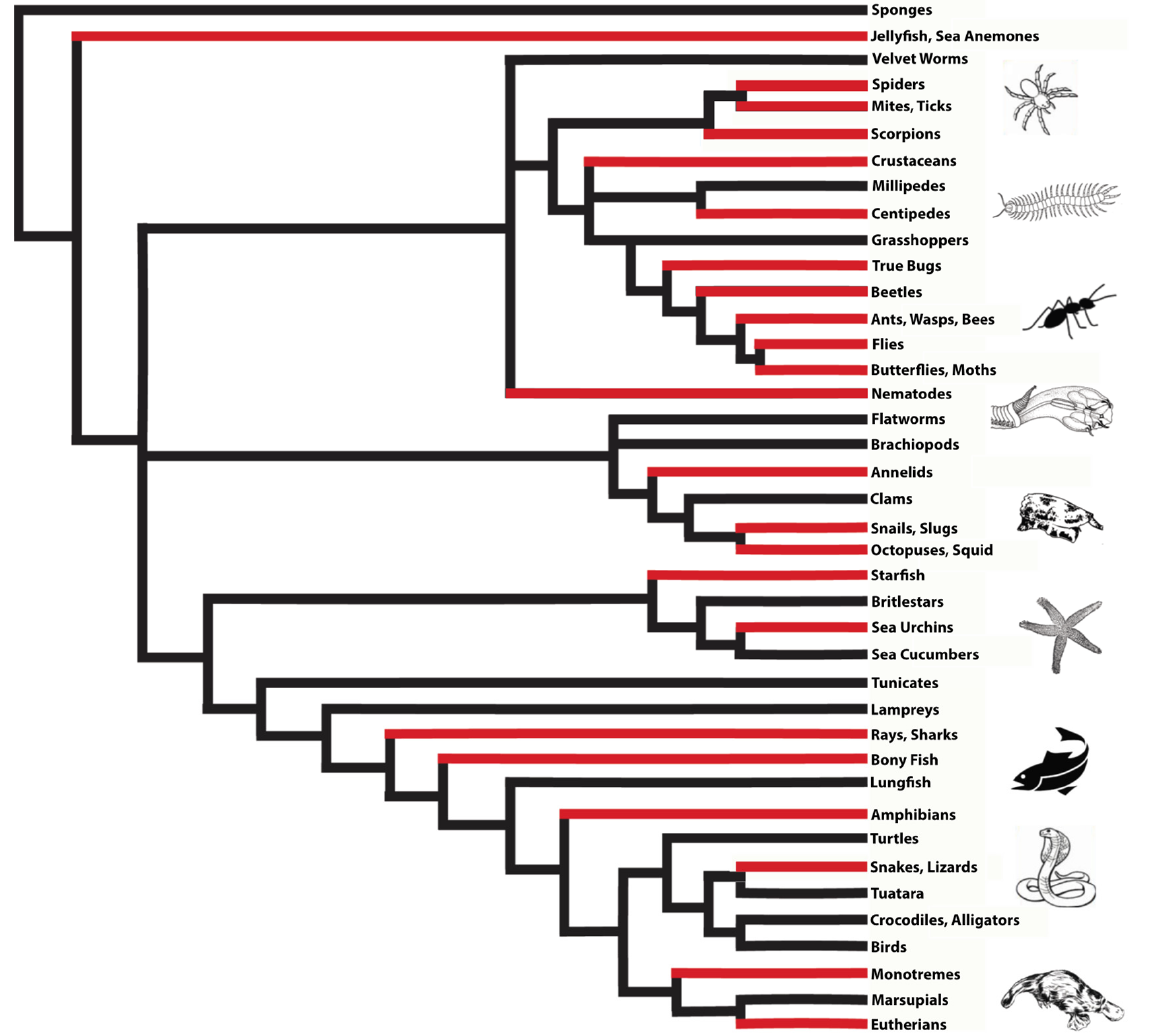
Figure 1. Evolutionary tree of animals (modified from [1]). Lineages with venomous representatives are indicated in red.